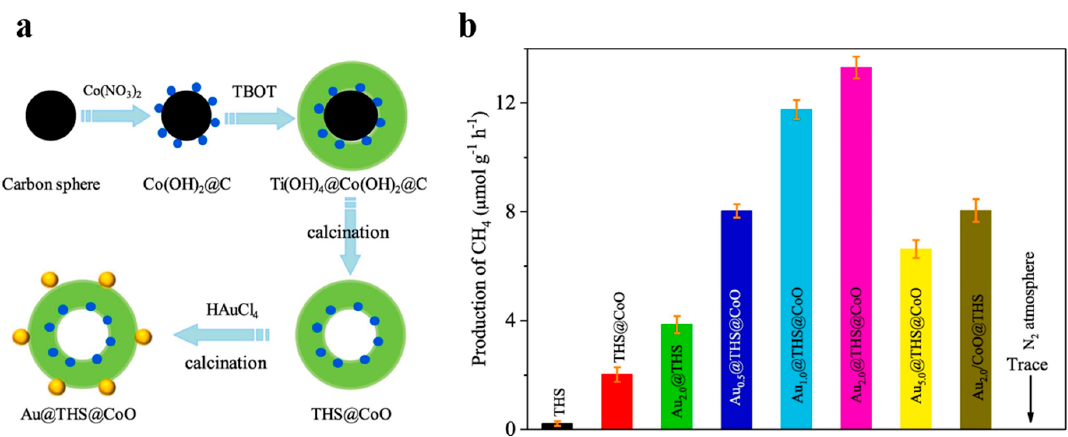
Figure 17. ( a ) Diagrams of preparation of Au x @THS@CoO. ( b ) Production rates of CH 4 for THS, THS@CoO and Au 2.0 @THS@CoO. Reproduced with permission from [103]. Copyright Elsevier, 2019.